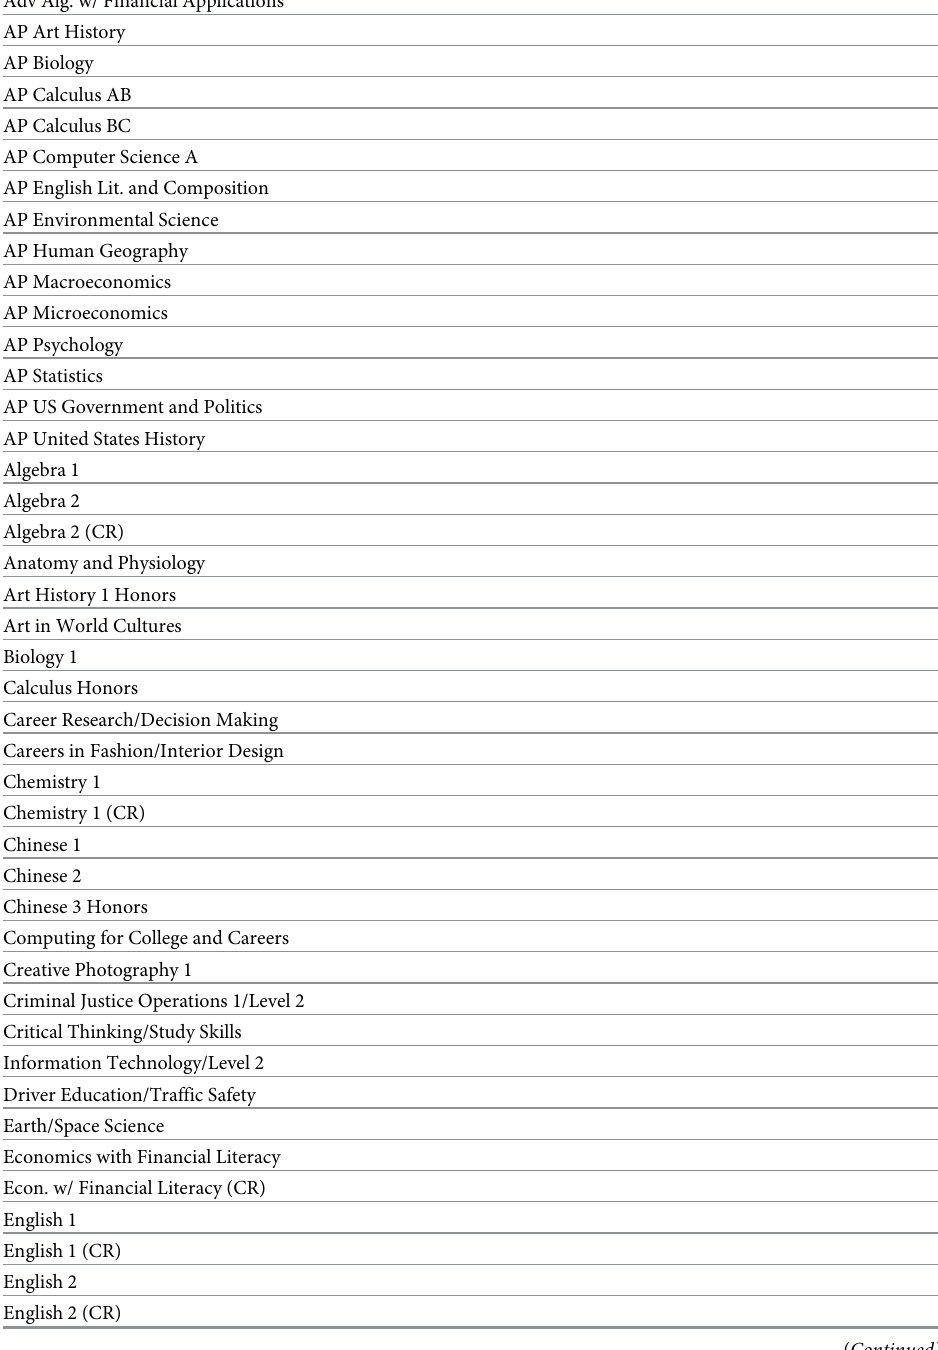
Table 1. FLVS courses included in